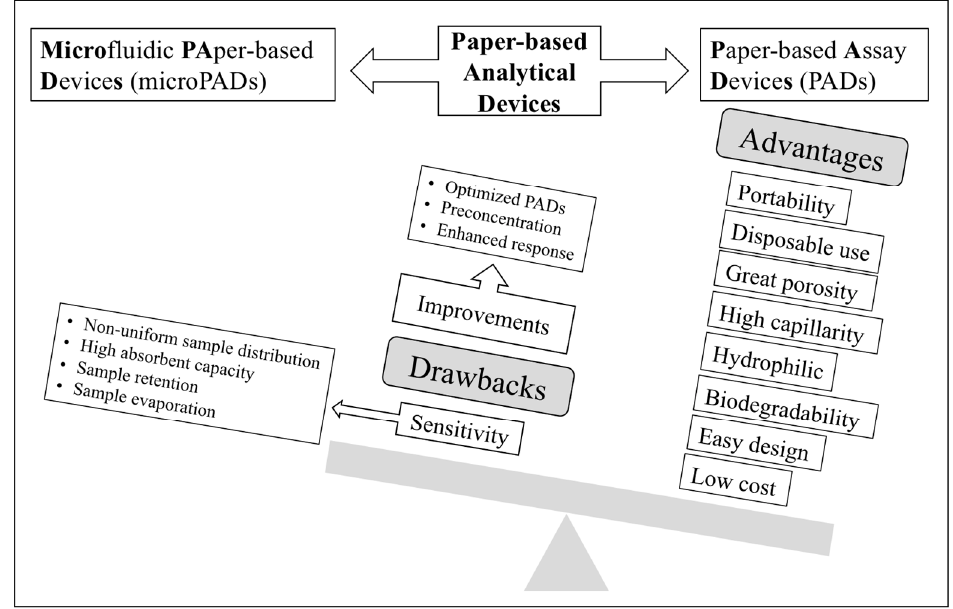
Figure 1. Schematic diagram showing the advantages and drawbacks of paper-based analytical devices as well as possible pathways for enhancing sensitivity.